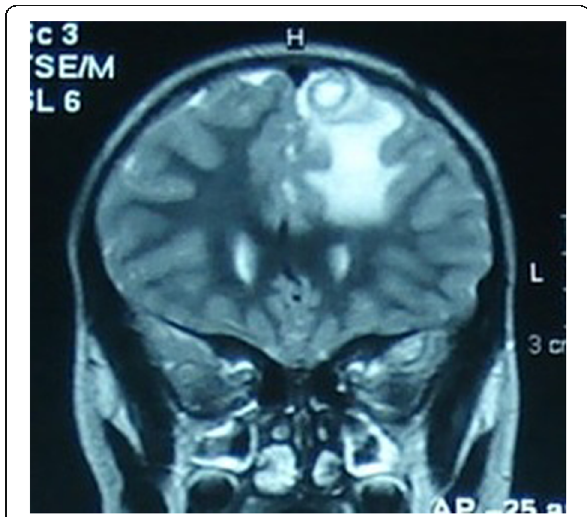
Fig. 2 Coronal T2W showing a hyperintense centre of the lesion with a peripheral hypointense rim and perilesional vasogenic oedema